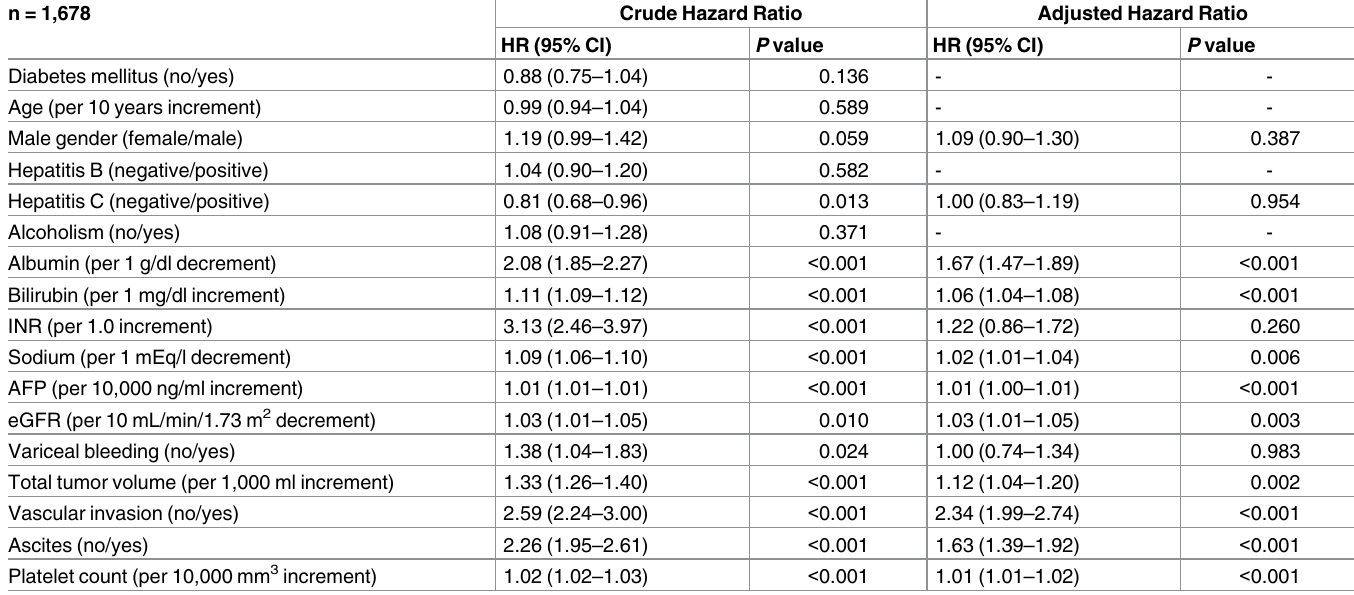
Table 5. Univariate and multivariate Cox survival analysis in patients with BCLC stage C and stage D hepatocellular